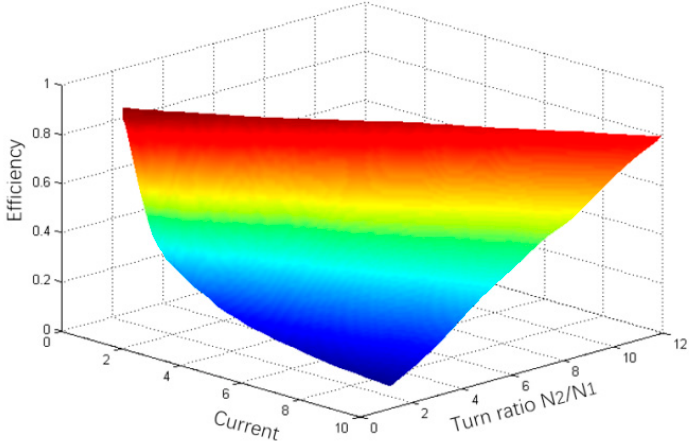
Figure 12. Three-dimensional curves of the efficiency under different current and turn ratio conditions.